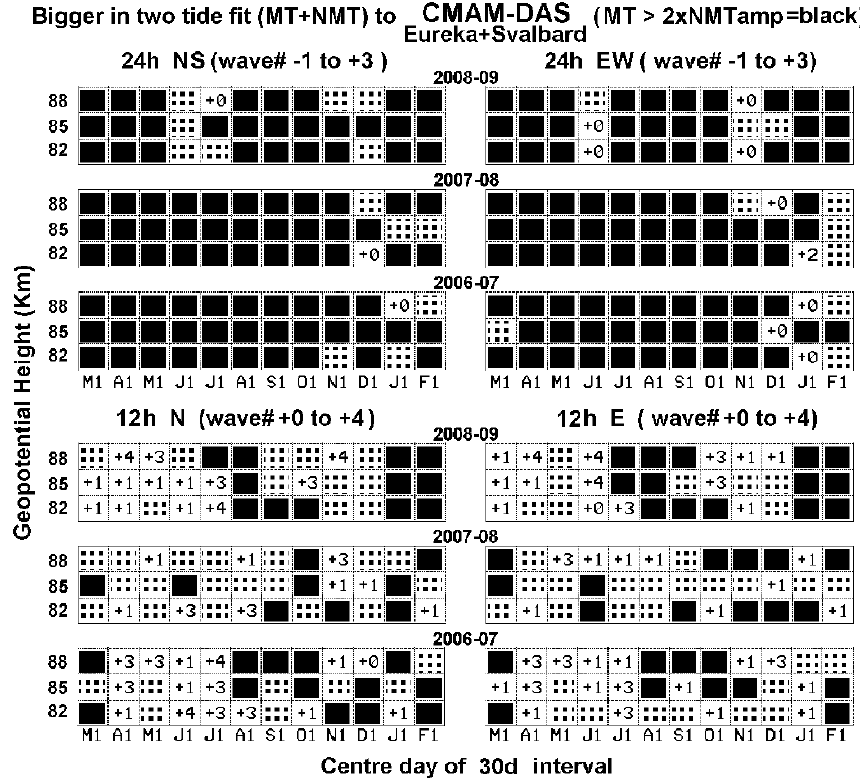
Fig. 9. Two-tide fits to the CMAM-DAS data for three separate years, using the wave number of the diurnal MT (DT, s = 1) plus one of a range of NMT (top set of plots), and semidiurnal MT (SDT, s = 2) plus one of a range of NMT (bottom set of plots), were used to find the relative sizes: a black square is chosen if MT is greater than twice any NMT value; a grey square is chosen when one or more NMT values are smaller then MT, but greater than 0.5 of MT; the wave-number “ s ” is chosen that has the largest NMT [relative to the corresponding MT amplitude] of all of the fits. Wave-numbers ( s =− 1 to + 3) for the DT and ( s = 0 to + 4) for the SDT are appropriate to non-linear interaction with the SPW S = 1 or